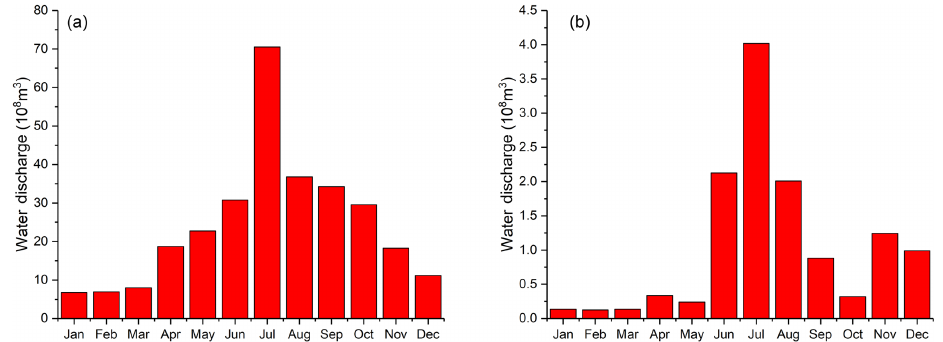
Figure 2. Monthly water discharge of the inflow at the main stem (a) and the tributary (the Bijiang River, b ) into the GGQ. Notice that the inflow from the tributary was estimated with the instant water discharge (m 3 s − 1 ). The instant water discharge was measured at the same time as the sampling campaign at point R2 at the Lanping or Yunlong hydrological gauging station, which was about 30km away from point